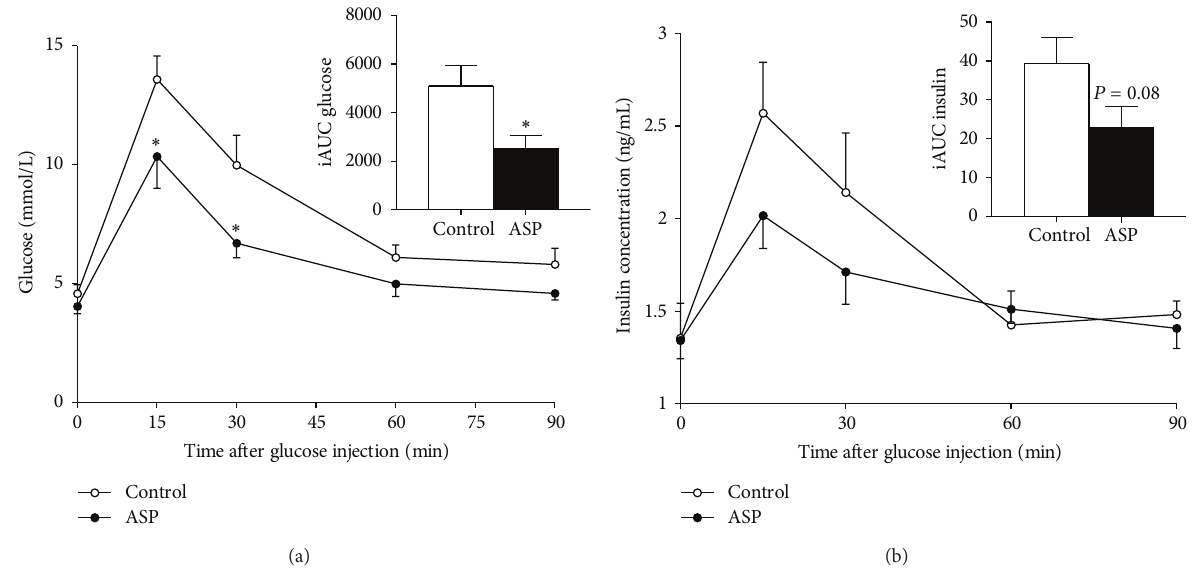
Figure 1: Glucose excursion is altered by ASP. Glucose with/without ASP was administered, and plasma glucose and insulin were measured over 90 minutes. Glucose levels are shown in (a) and concomitant insulin levels in (b). Incremental area under the curve for each graph is shown in the insert. Data are presented for glucose (mmol/L, (a)) and insulin (ng/mL, (b)). Results are expressed as mean ± SEM where differences versus controls (vehicle) are expressed as ∗ 𝑃 < 0.05 , with 𝑛 = 7-8 per group.